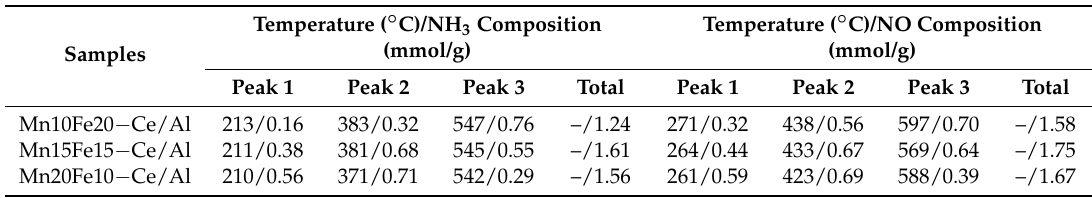
Table 4. Quantitative analysis of NH 3 -TPD profiles.